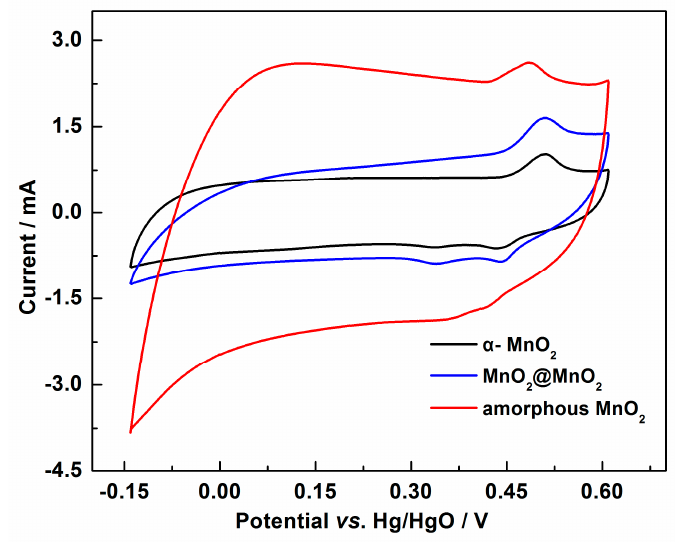
Figure 5. CV curves of the α -MnO 2 , MnO 2 @MnO 2 and amorphous MnO 2 electrodes at scan rate of 5 mV·s − 1 .